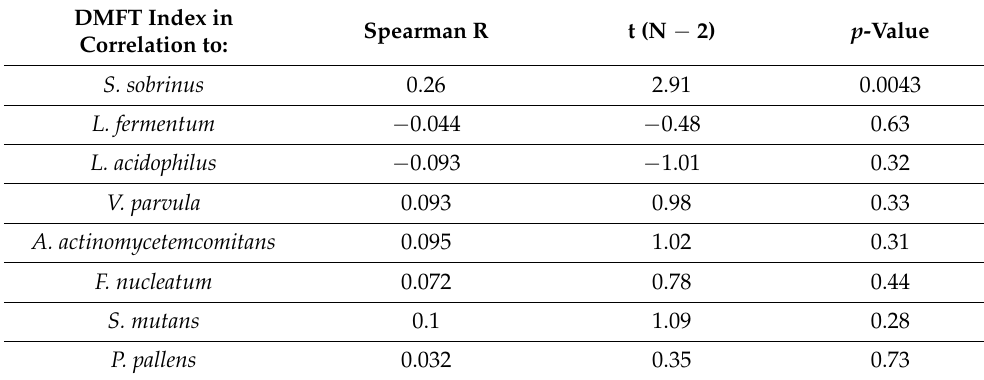
Table 3. Correlation of bacterial species abundance with the DMFT index.